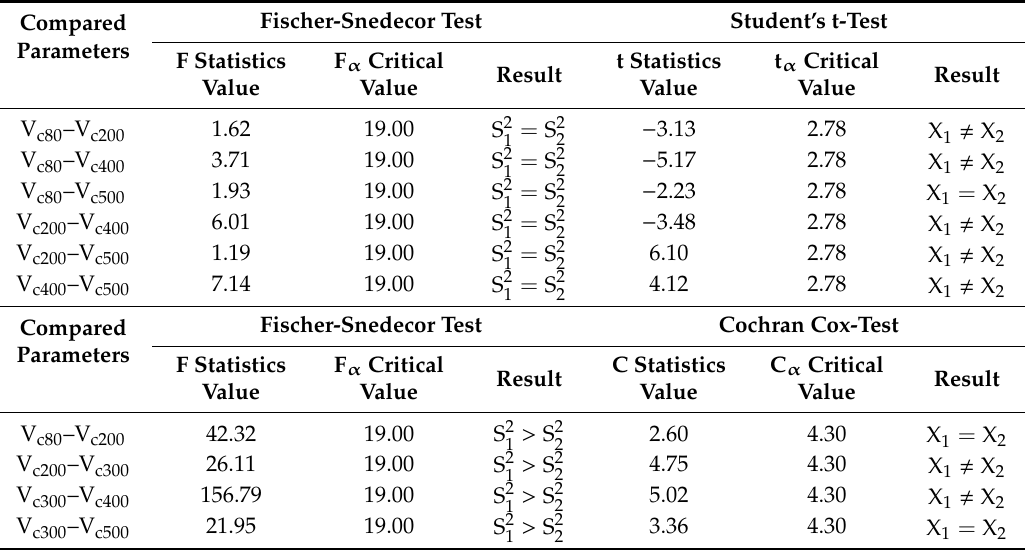
Table 7. Results of statistical analysis for V c variable during milling from composite layer (CFRP / Al) [28]. Compared